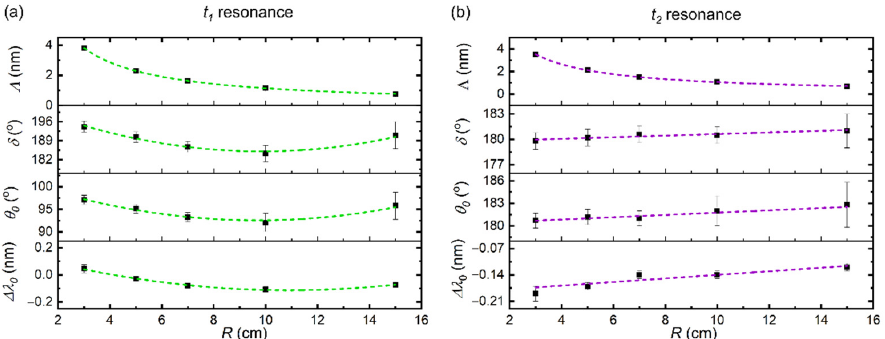
Figure 5. Parameters ∆ λ 0 , θ 0 , δ , and Λ as a function of the curvature radius ( R ), corresponding to the